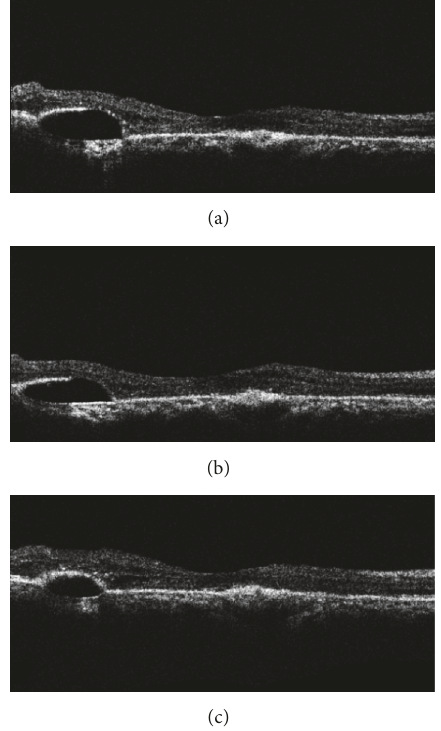
Figure 3: Right eye posttreatment sequential OCT scans demonstrat- ing reduction in PED height and regressing CNVM . (a) After 1st injection, (b) after 2nd injection, and (c) after 3rd